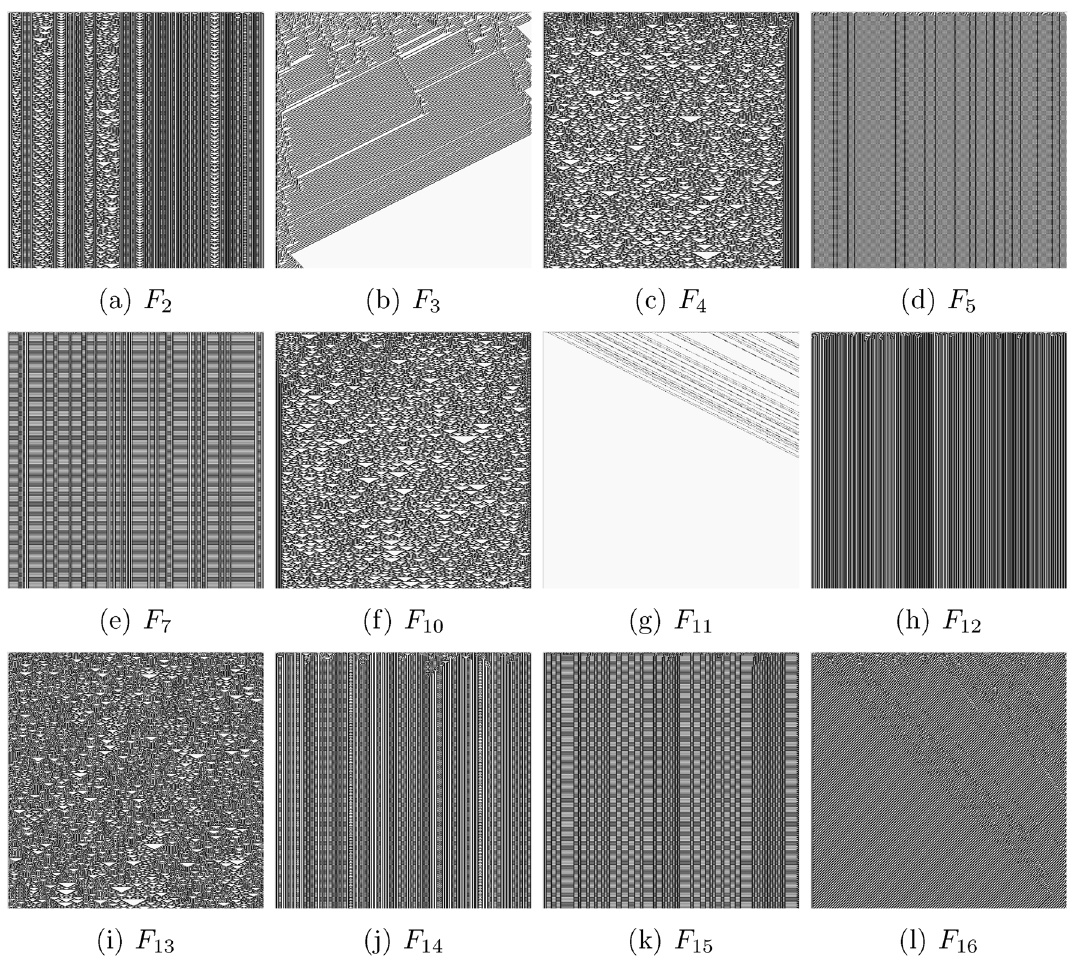
Figure 5. Space-time configurations of one-dimensional cellular automata governed by functions from Table 1. An automaton has 500 cells and evolves for 500 iterations. Initial configurations has a random uniform distribution of cells in state ‘1’ where each cell takes the state ‘1’ with a probability 1 2